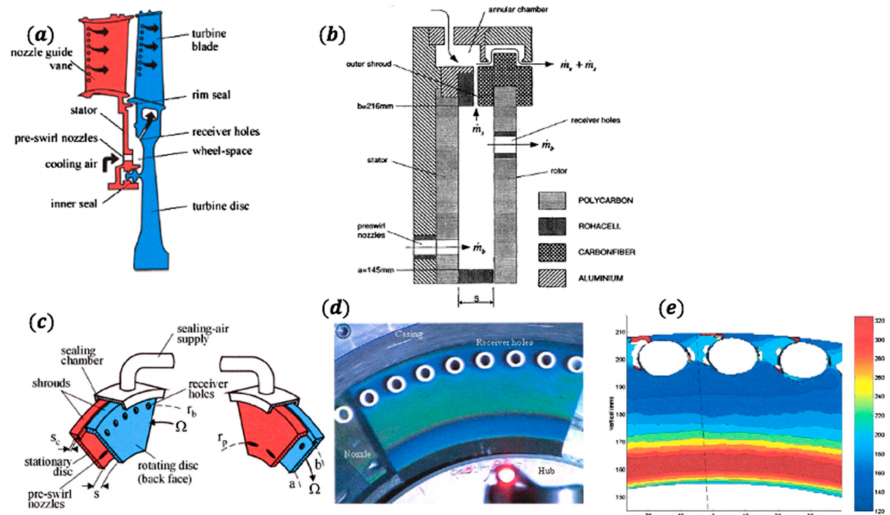
Figure 14. ( a ) Typical pre-swirl flow system, ( b ) test-section cross-section, ( c ) schematic of the test section, ( d ) sample liquid crystal color change snapshot during the experiment, ( e ) local heat transfer coefficient map in the vicinity of receiver holes and the azimuthally symmetric nature in the radially inboard regions. [53]. Reprint with permission from ASME (order number